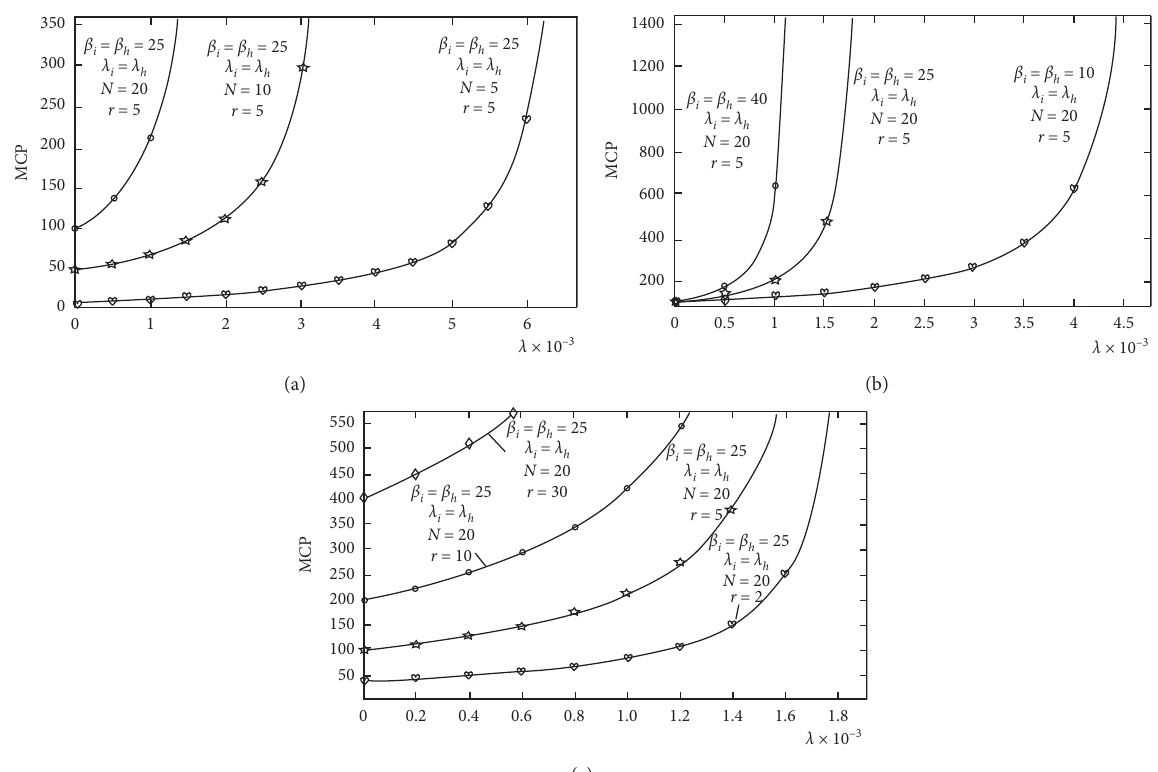
Figure 4: The change trend of MCP. (a) Range of MCP with λ ′ s change under different N . (b) Range of MCP with λ ′ s change under different β. (c) Range of MCP with λ ′ s change under different r